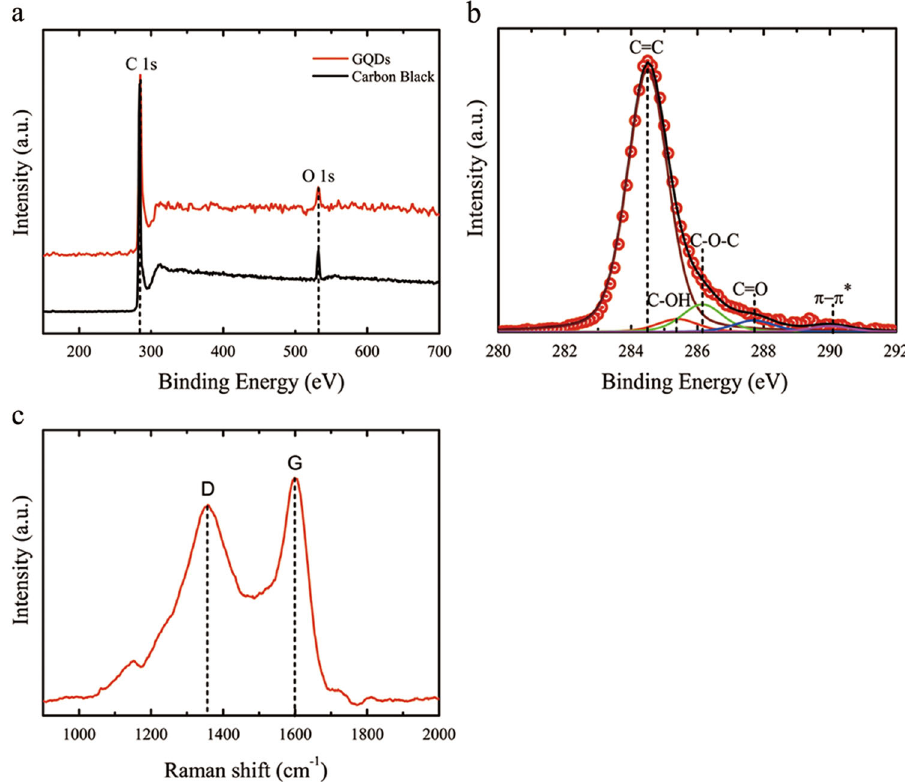
Fig. 3 a XPS spectra of GQDs and the original carbon black over a wide range of binding energies (150 – 700 eV). b Fine-scanned C 1 s XPS spectrum of GQDs. c Raman spectrum of